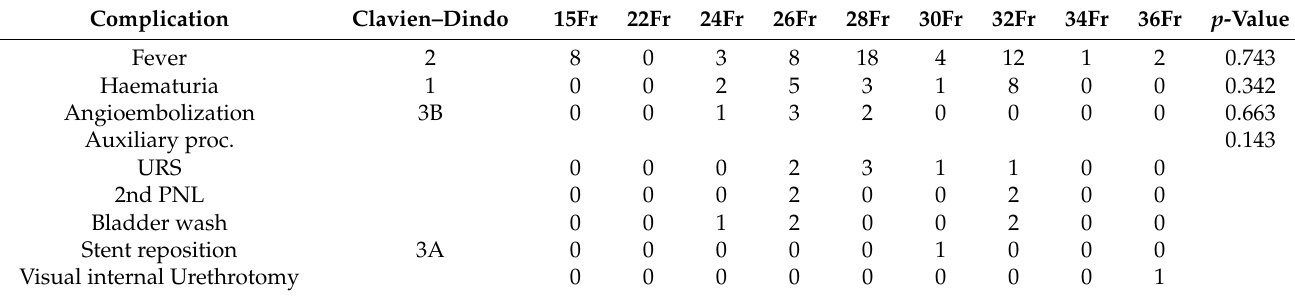
Table 1. Clavien–Dindo complications after percutaneous nephrolithotomy (PNL): n = 517. Complication